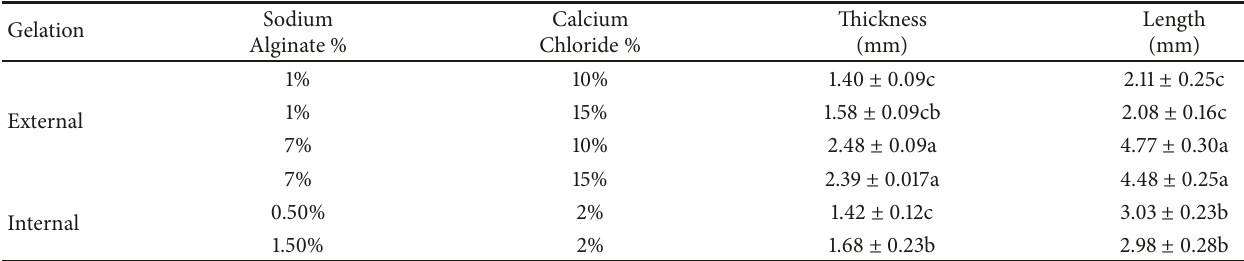
Table 2: Mean length and thickness of spirulina-alginate beads.